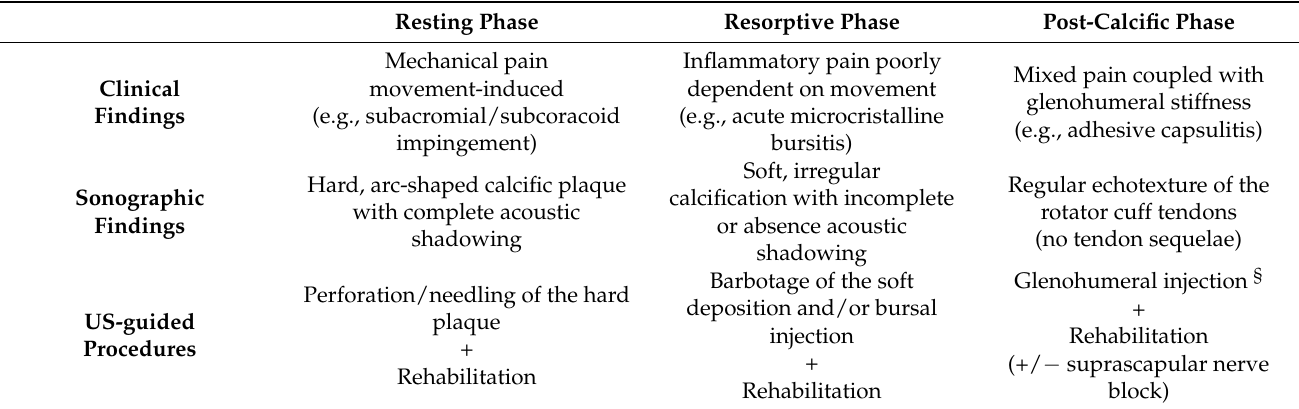
Table 1. Clinical/sonographic ‘look’ on the Uhthoff